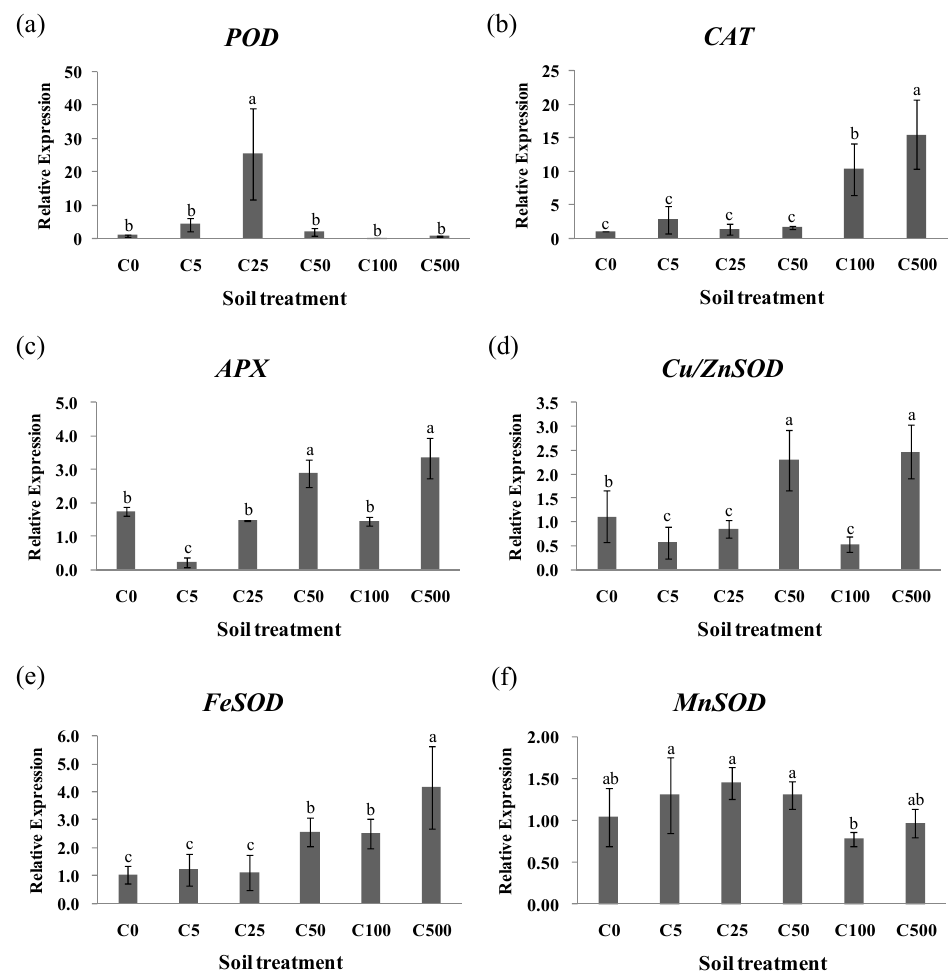
Figure 3. Gene expressions of ( a ) POD , ( b ) CAT , ( c ) APX , ( d ) Cu/ZnSOD , ( e ) FeSOD and ( f ) MnSOD in ryegrass leaves under Cd stress. Values are the means of three replications ± SD. Different lowercase letters indicate significant difference among treatments ( p < 0.05).